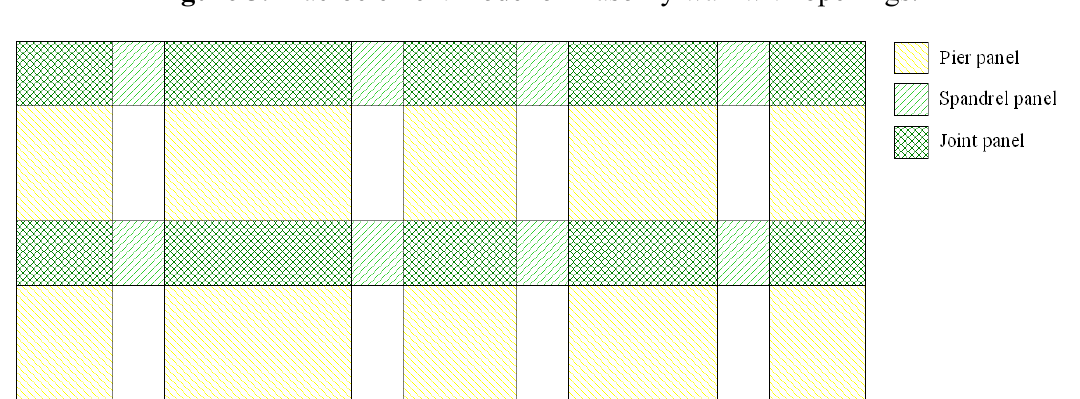
Figure 3. Macroelement model of masonry wall with